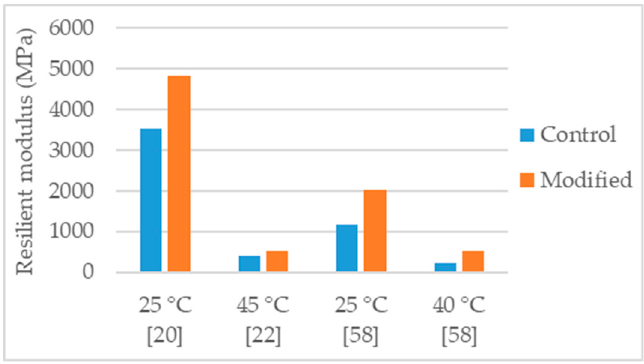
Figure 6. Resilient modulus of control and nanosilica modified asphalt mixtures.